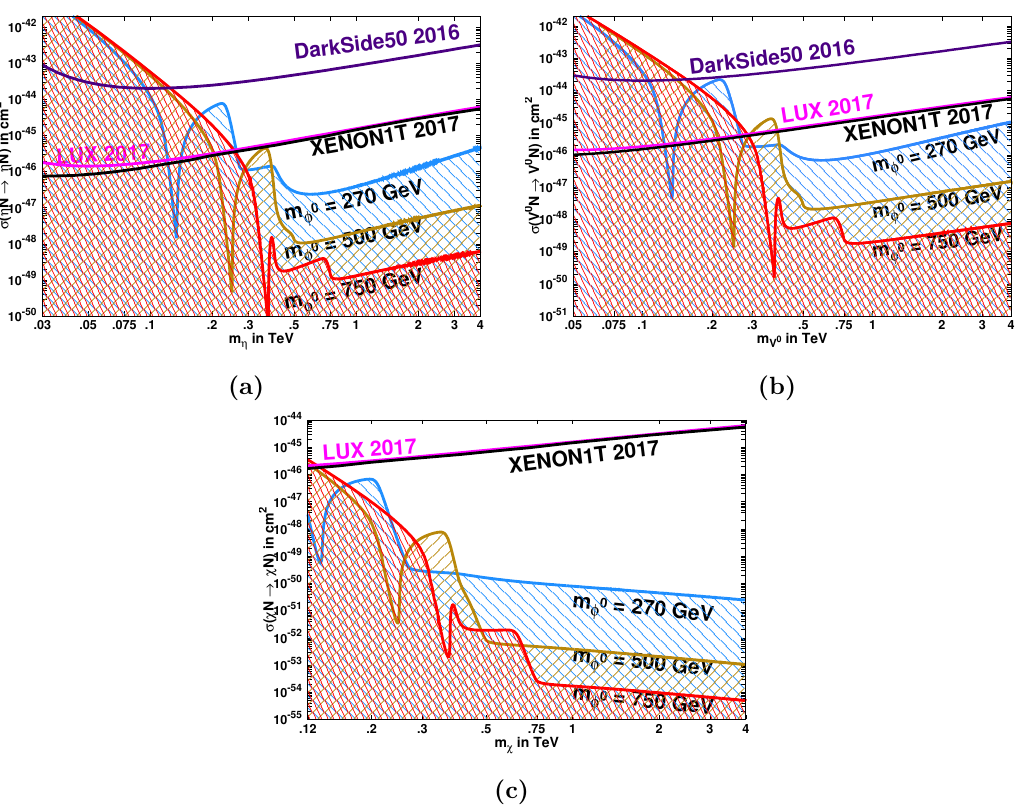
Figure 10. The spin-independent DM-nucleon elastic cross-sections are depicted as a function of DM mass for the scalar, vector and fermionic dark matter in (cid:12)gures 10a, 10b and 10c respectively. In each of the (cid:12)gure three graphs are exhibited for the (cid:12)xed VLQ mass 400 GeV and scalar portal masses 270, 500, 750 GeV respectively. All the cross-sections are drawn for the upper limit on the respective DM couplings allowed by the relic density constraints for a given DM mass. We have also exhibited the experimental cross-section from LUX (2017) [17, 18], XENON (2017) [19] and Dark-Side50 (2016) [16]. Shaded regions appearing in blue, golden yellow and red correspond to the relic density forbidden regions for the portal masses of 270, 500 and 750 GeV